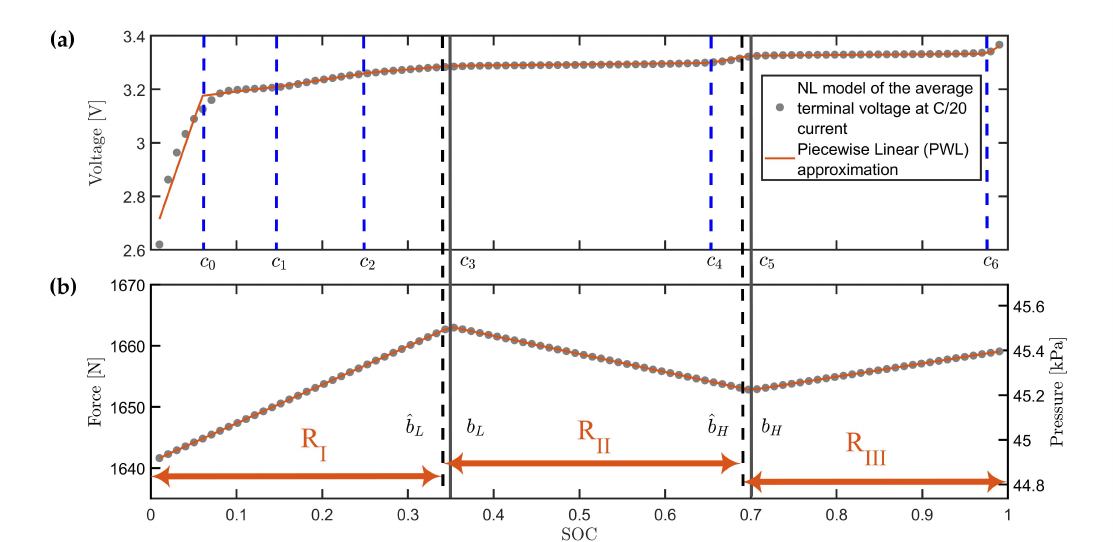
Figure 3. A piecewise linear approximation of the ( a ) open circuit voltage and ( b ) cell swelling force was fit to the experimental measured values for the A123 Lithium Iron Phosphate Battery Cell. The gray dots correspond to the average of measured data at each SOC point from the charge and discharge cycles at the C rate (see Figure 1). The orange line represents the PWL fit. The horizontal solid lines 20 represent the inflection points of the cell swelling force. The horizontal dashed black lines represent the inflection points of the cell swelling force used for the developed observers. R I , R II , and R III represent the force slope regions determined by our PWL model. For the PWL force model, we assume b L = c 3 and b H = c 5 since the changes in voltage and force slopes are due to the intrinsic phase transitions in the material of the battery electrodes [15]. Assessment of the SOC estimator robustness is performed by imposing ˆ b L (cid:54) = b L and ˆ b H (cid:54) = b H to capture model mismatch for the force and voltage behavior. For generalization of the results to the other cell sizes, the pressure is